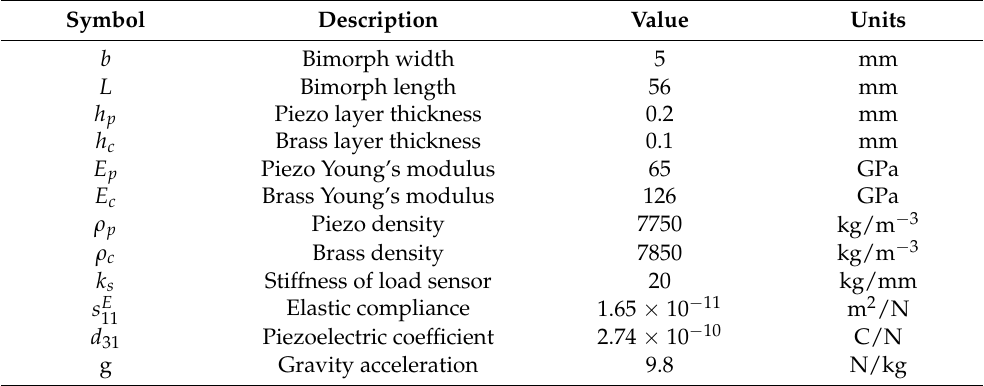
Figure 1. ( a ) Schematic of the bimorph in the proposed PEH; ( b ) The measured and theoretical resonance frequency versus preload. Table 1. Variable descriptions and their values.